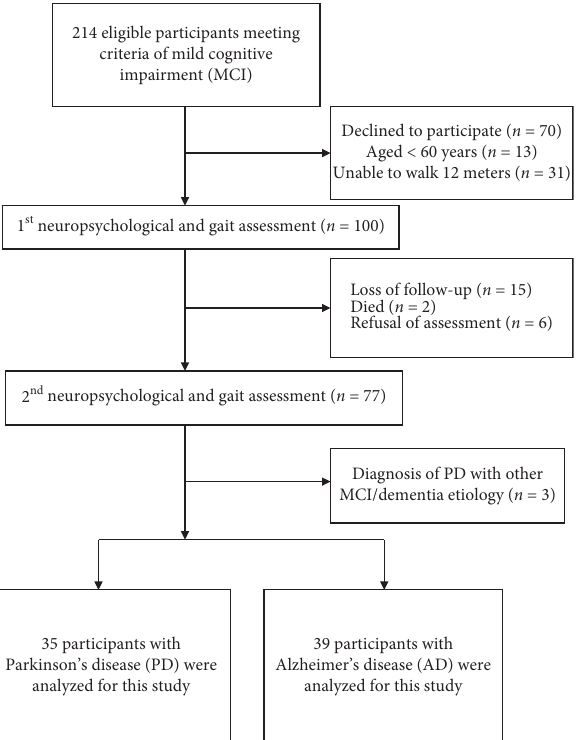
Figure 1: Flow chart of the selection of participants in this